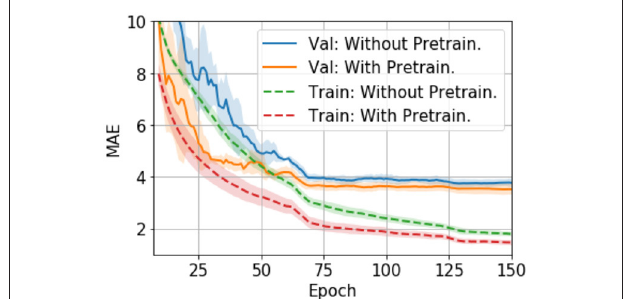
FIGURE 4 | Training curves for transfer learning. The curves are averaged by five models trained with 5-fold cross-validation splitting, and then smoothed with a 7-step averaging window. The shading areas show the standard deviation within the window.